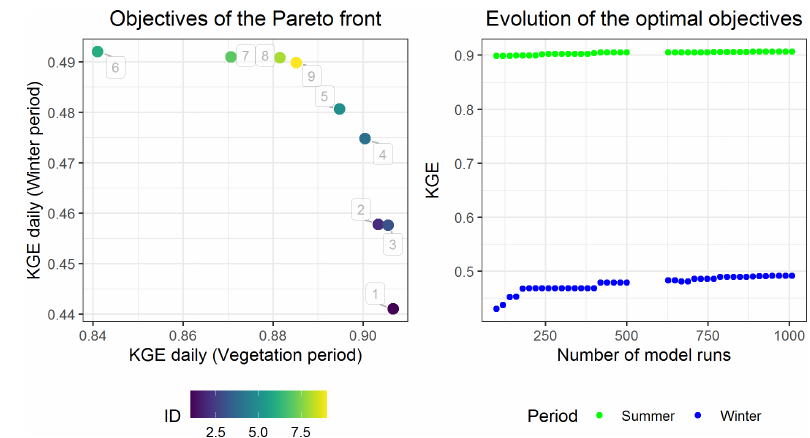
Figure C1. Resulted calibration Pareto fronts for Grillenburg (chosen ID – 9).